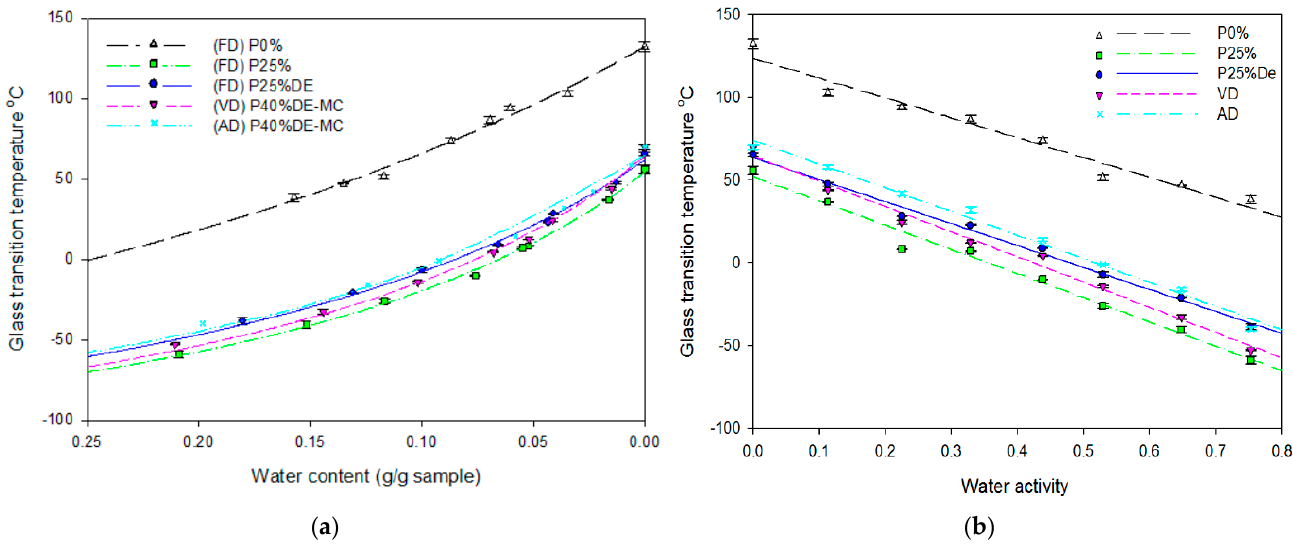
Figure 3. Changes of the glass transition temperature of selected dried gels to ( a ) water content; ( b ) water activity.